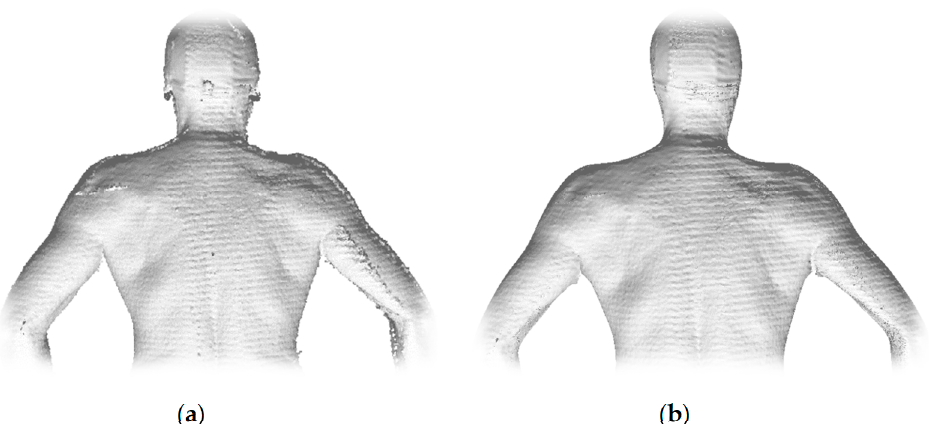
Figure 5. Comparison of raw ( a ) and smoothed ( b ) scans.